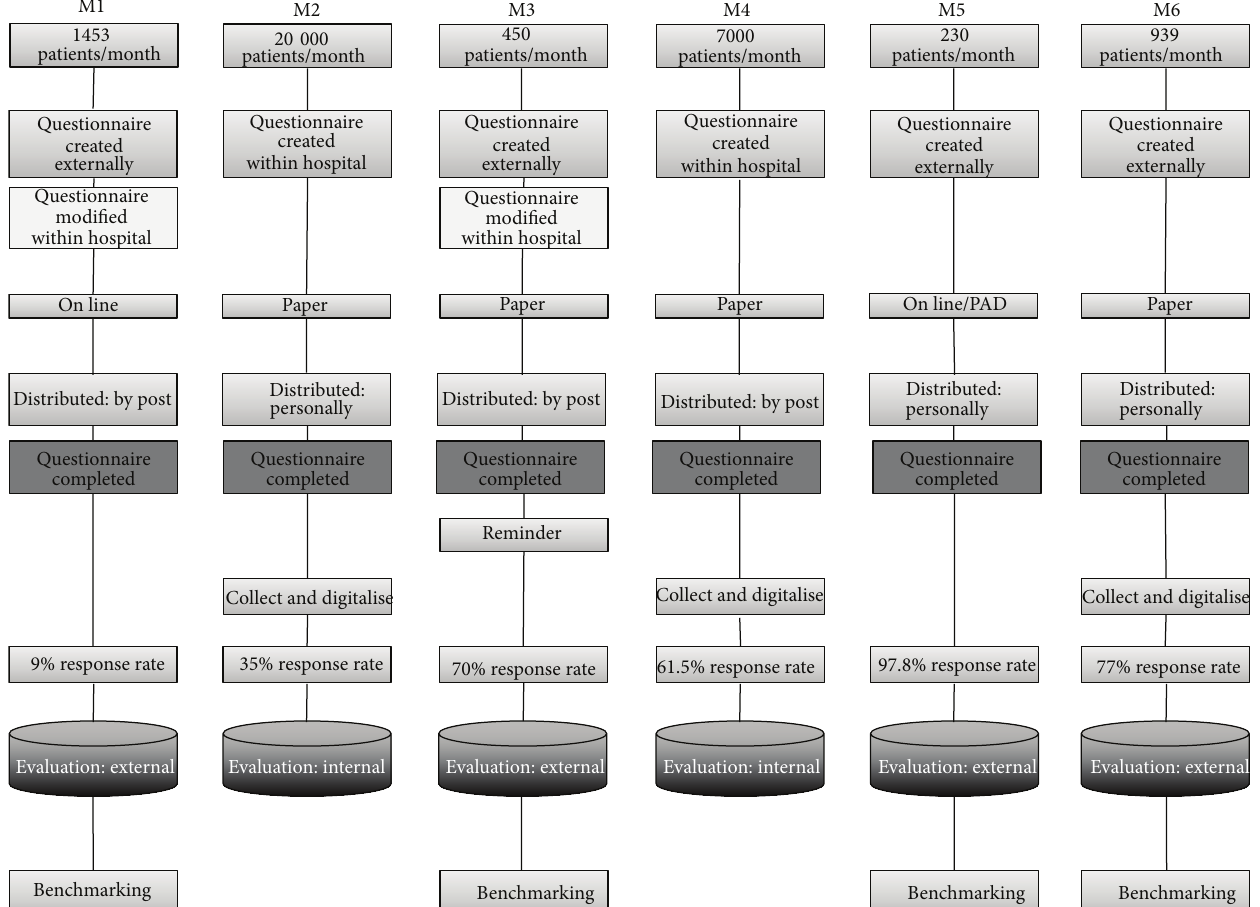
Figure 1: Characterisation of the recorded methods on the assessment of patient